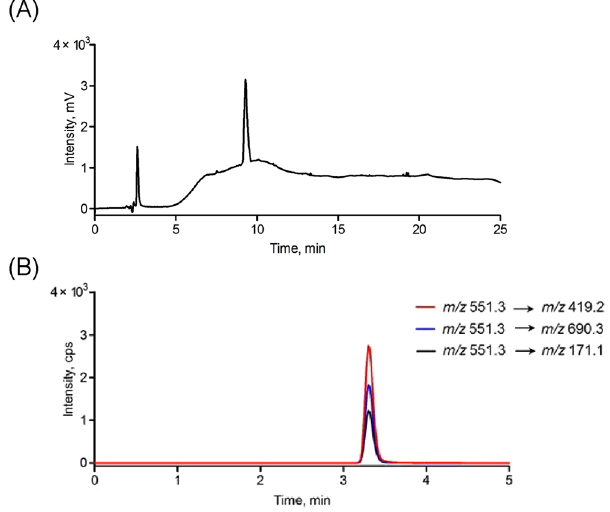
Figure 5. ( A ) HPLC chromatogram (260 nm) and ( B ) LC-MS/MS chromatogram of the trypsin digestion products of DNA-peptide